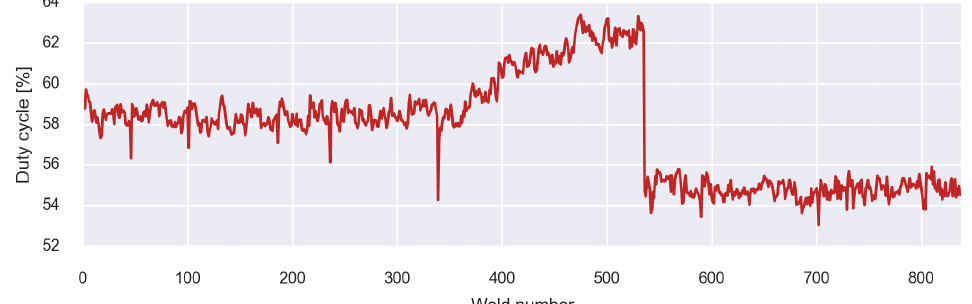
Figure 3. Analysis of secondary wear through duty cycle.The main problem with this method is that not all elements that wear cause a drastic increase in the overall resistance of the secondary, but sometimes, if the resistance of the arm is high, an increase in wear in a low-resistance element does not cause a noticeable increase in duty cycle, being difficult to detect it with the initial method.